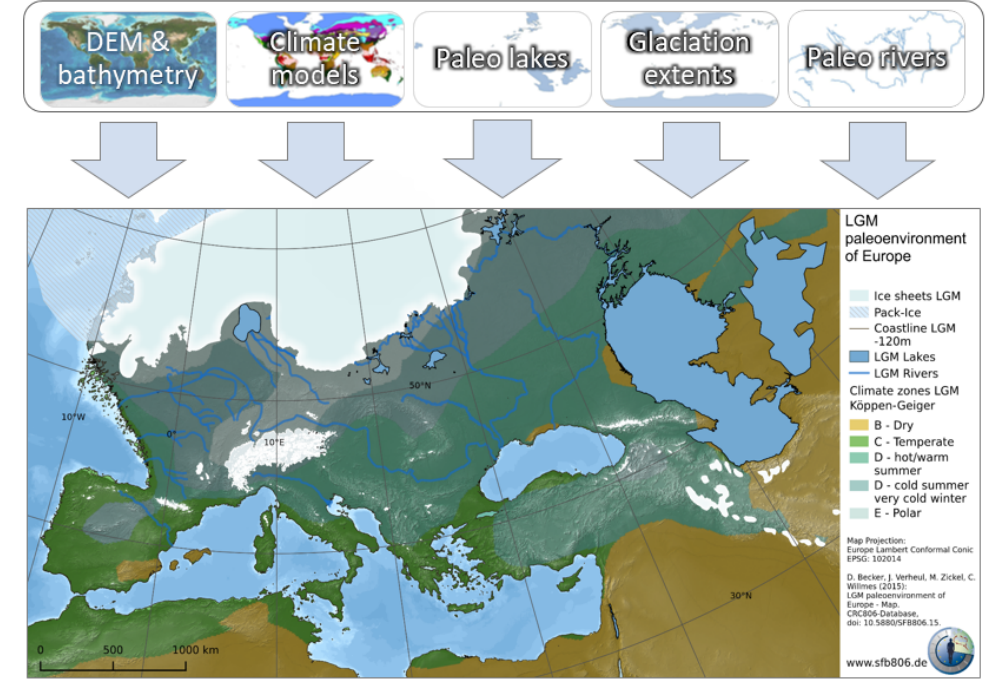
Figure 2. A PaleoMap is a geographic information system (GIS) based model of a paleoenvironment reconstruction, consisting of several data sources, for example a paleo digital elevation model (DEM), a paleo climate model, a paleo hydrology model, and glaciation extends. Example PaleoMap-LGM Paleoenvironment of Europe